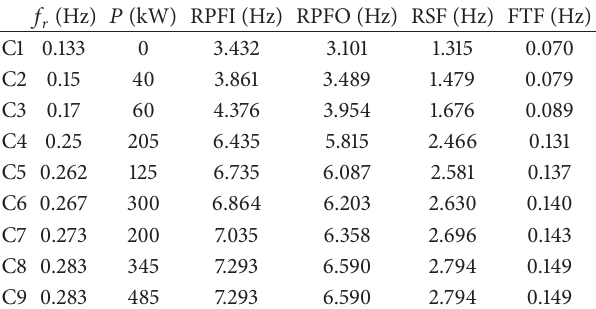
Table 1: 9 operation conditions and the fault feature